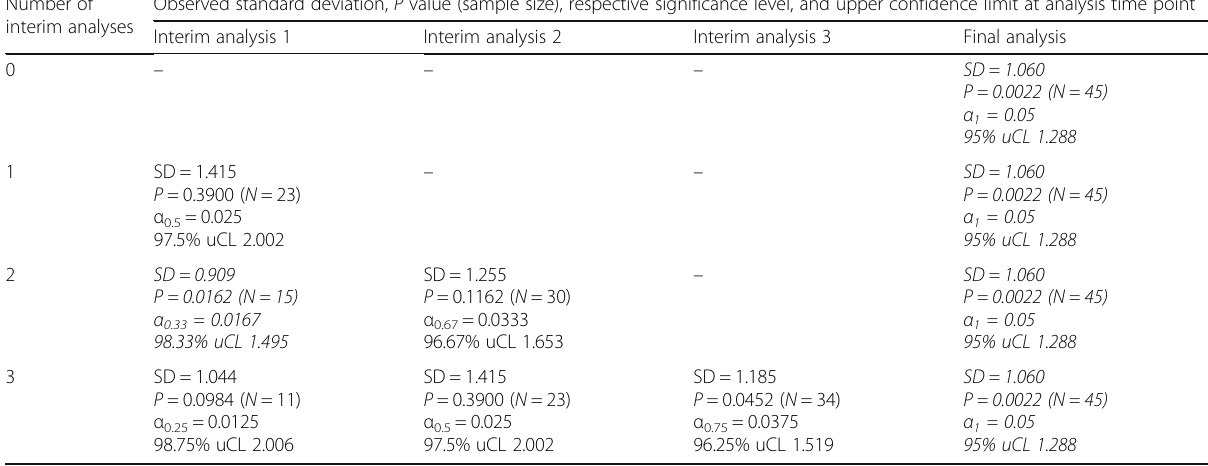
Table 2 Sequential testing on population standard deviation σ Number of Observed standard deviation, P value (sample size), respective significance level, and upper confidence limit at analysis time point interim analyses